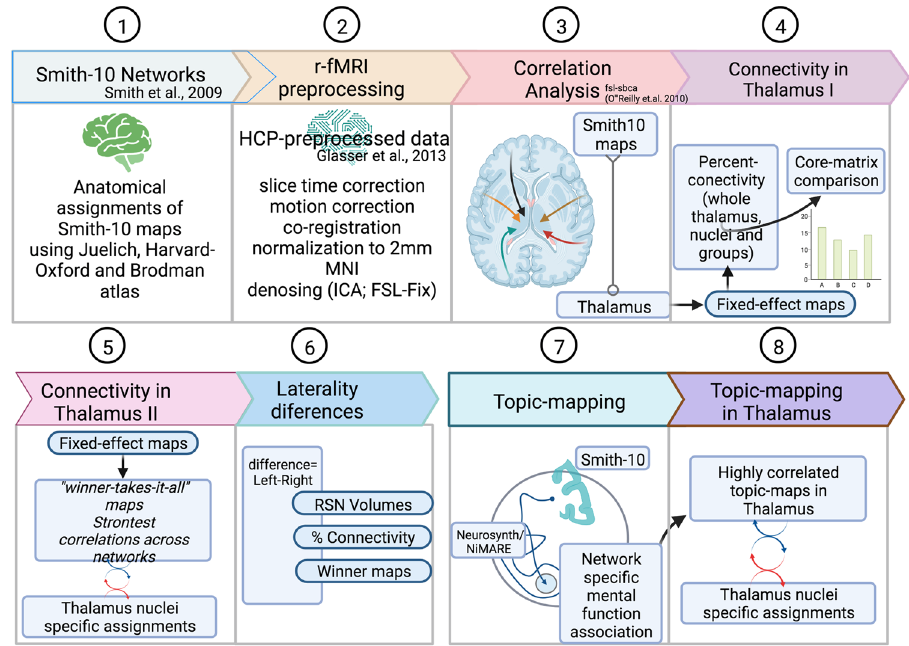
Fig. 10 Analysis work fl ow. Work fl ow summarized according to the performed steps. (1) The fi rst analysis relates to the anatomical assignments of the Smith-10 maps. (2 – 6) Correlation analysis between large-scale functional networks (Smith-10) and thalamus. 2: The mentioned preprocessing steps outline the major steps in the graphical illustration. The HCP minimal processing pipeline includes a more detailed overview of the preprocessing work fl ow (see Figs. 7 and 8 in Glasser et al. 110 ), topic analysis of Smith-10, and visualizing highly correlated topics within the thalamus. Figures are designed using